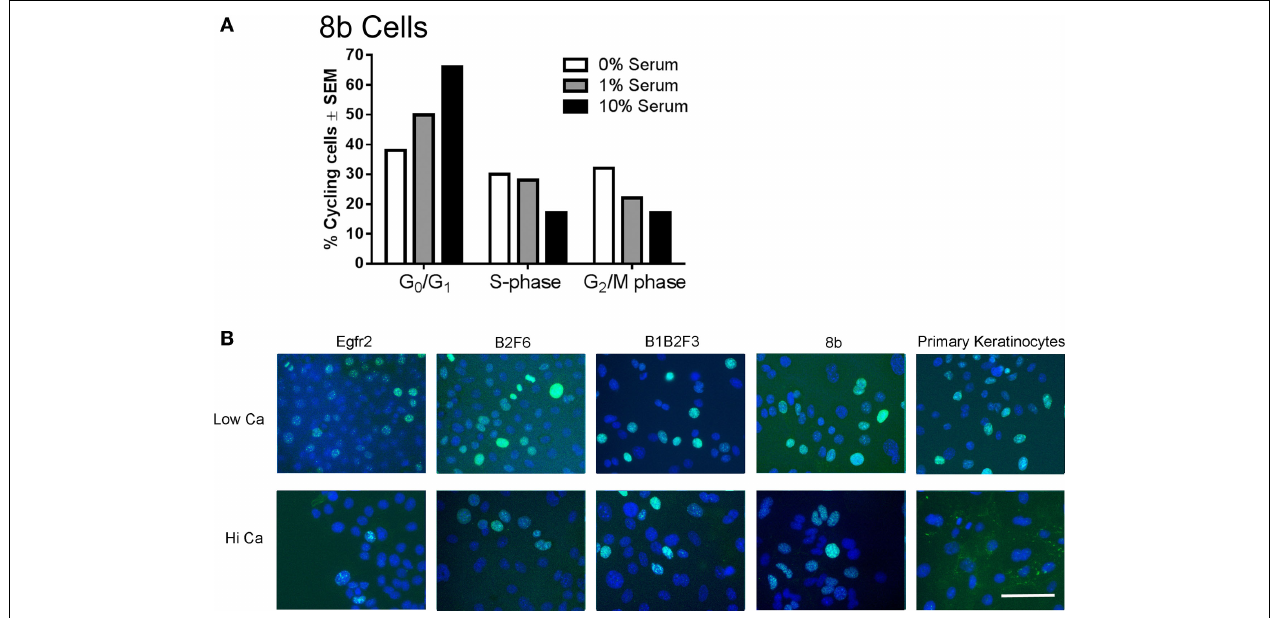
(P42), immortalized B2F6 cells (P42), immortalized B1B2F3 cells (P29), immortalized 8b cells (P53), or primary keratinocytes from FVB/N mice were treated with LoCa or HiCa media for 48h, and immunofluorescence was performed for proliferation marker Ki67 (green). DAPI indicates the nuclei (blue). Scale bar indicates 20 μ m.